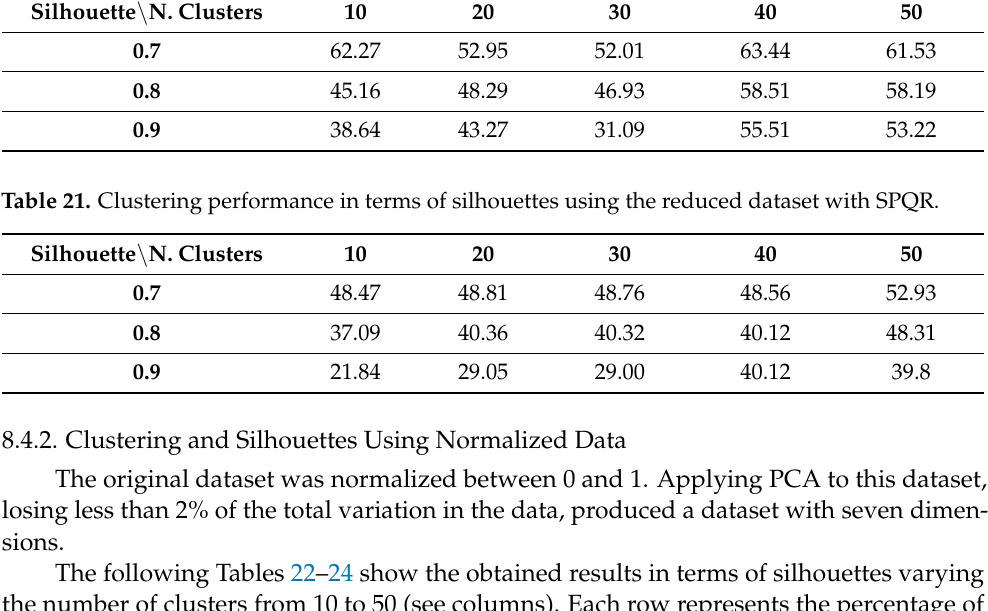
Table 20. Clustering performance in terms of silhouettes using the reduced dataset with PCA. Silhouette \ N. Clusters